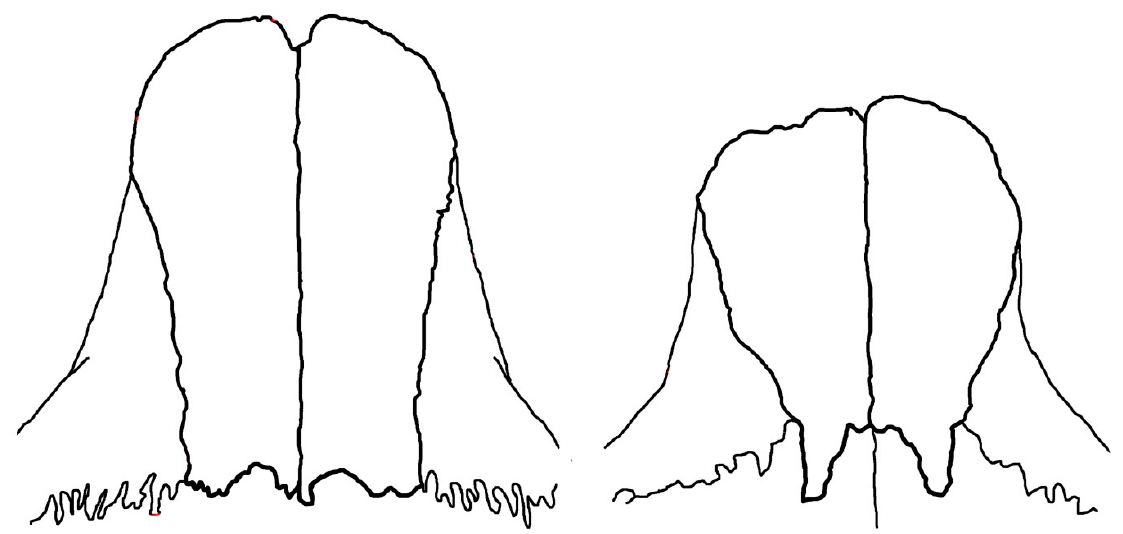
Figure 4. The schematic drawings of the rostra (viewed from above), showing shape of the nasofrontal suture in the specimen S-207534 (to the left ) and the syntype of Petinomys setosus (to the right